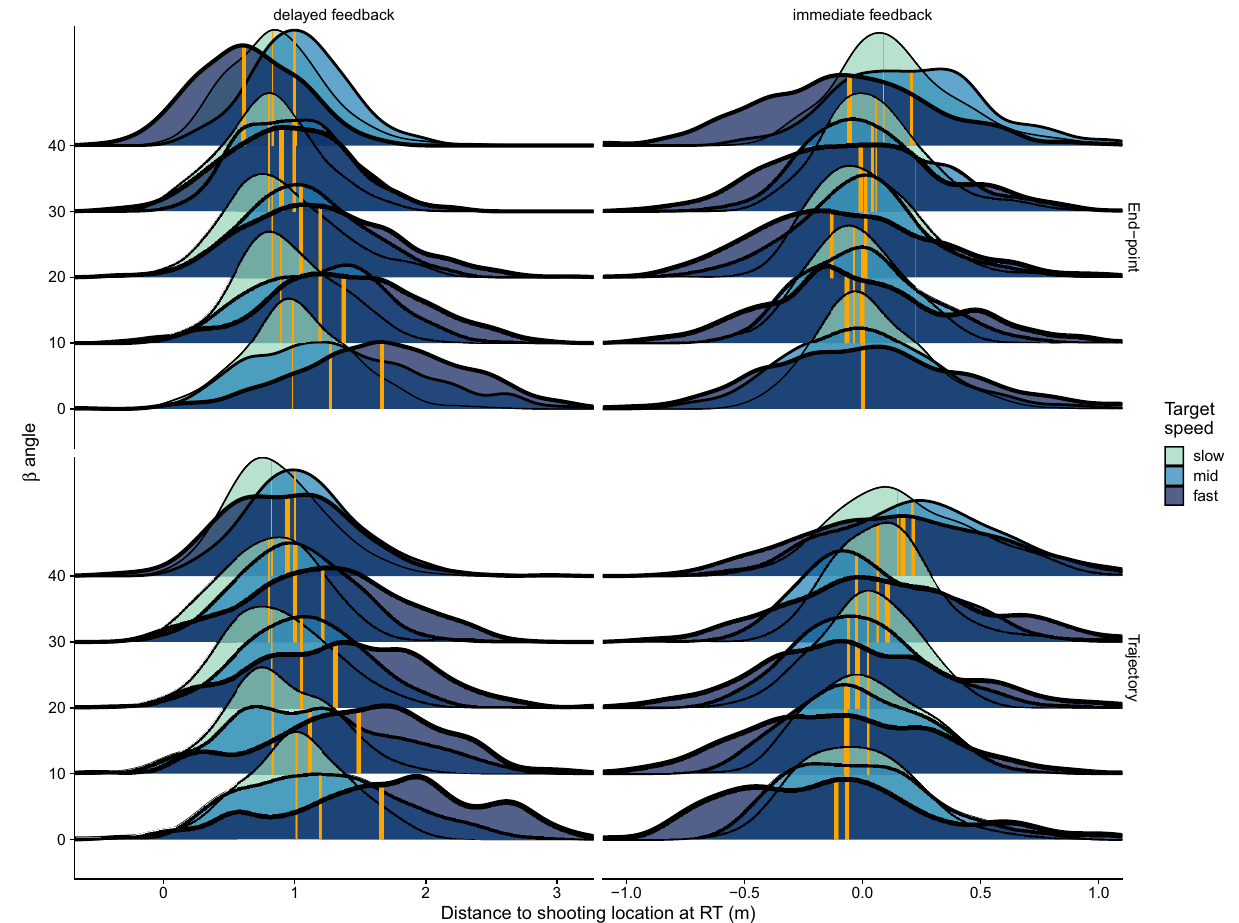
Figure 7. Distributions of distance between target and the shooting location at the moment of the response for the two conditions (column-wise panels) and tracking strategy (row-wise panels). Within each panel we show the densities for the different angles ( β values) and target speeds (different fill color and line width). The vertical orange lines denote the medians of the corresponding distribution (the thicker the line the faster the